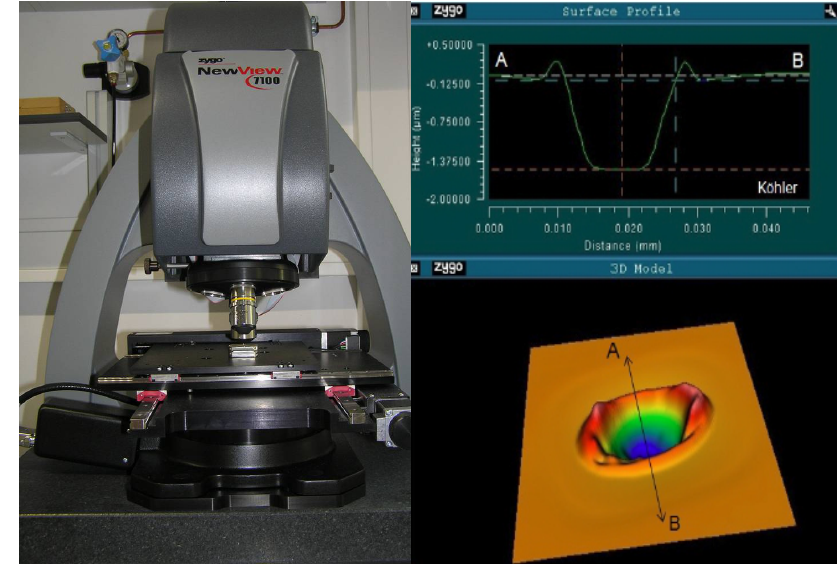
Figure 2: The New View 7100 optical profilometer (left). Example of a data set from the profilometer which can determine the geometry of the SIMS carters with a resolution of 500 nm in X and Y and 1 nm in the Z dimension. This allows us to determine crater volume and test portion mass of our various analytical methods